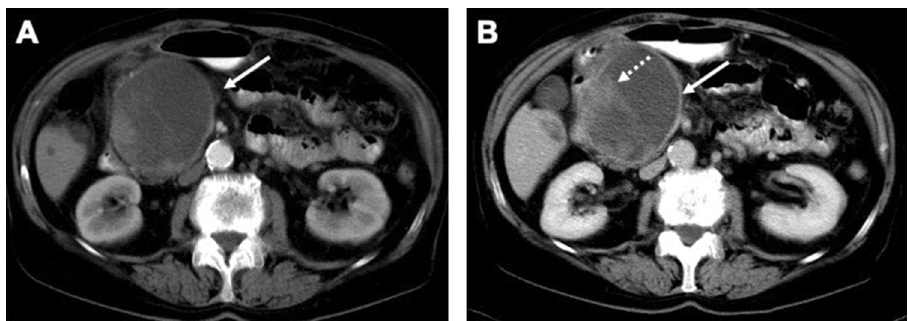
Figure 4. ITPN mimicking the morphology of mucinous cystic neoplasm. ( A,B ) Axial CT scans in the arterial phase ( A ) and portal venous phase ( B ) demonstration a huge oligocystic mass (arrow) in the pancreatic head with an enhancing solid nodular component (dotted arrow).